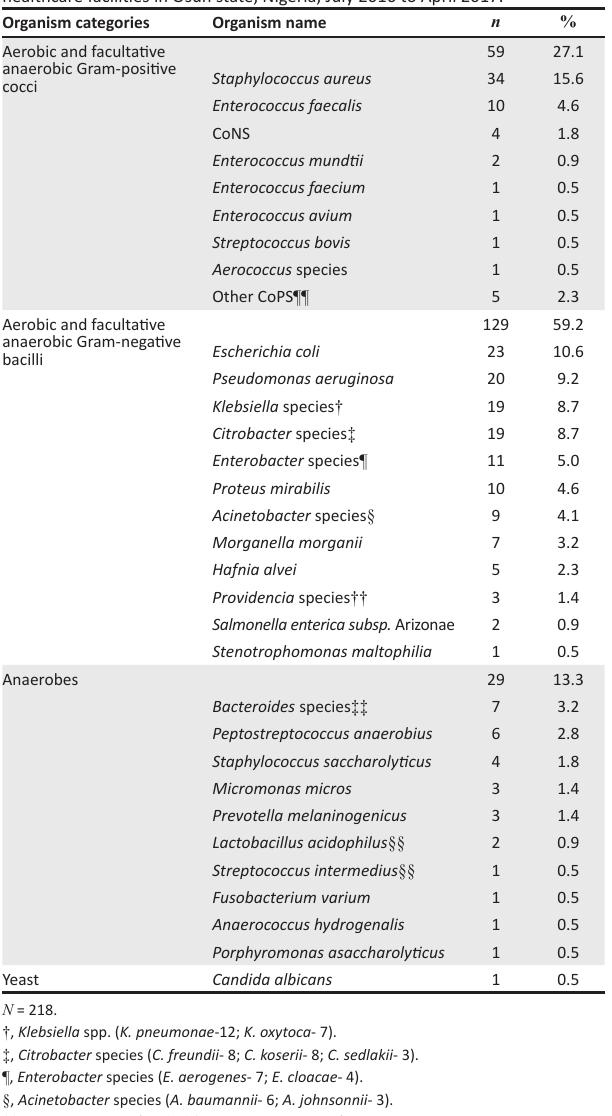
TABLE 4: Prevalence of multidrug resistance among bacterial isolates from infected diabetic foot ulcer patients from tertiary healthcare facilities in Osun state, Nigeria, July 2016 to April